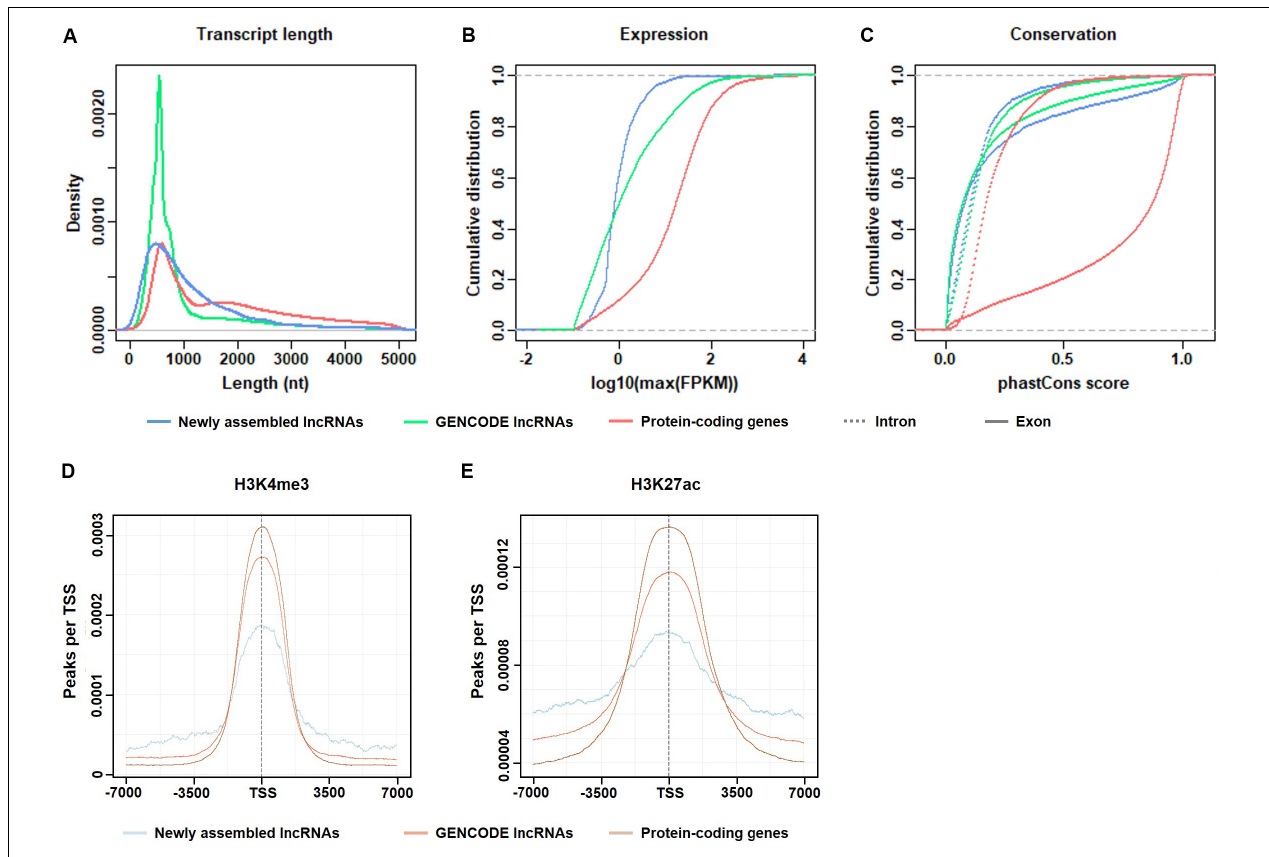
FIGURE 2 | Basic features of the candidate lncRNAs. (A) Length distribution of the transcripts. (B) Maximum expression level (FPKM) of the transcripts. (C) Exonic/intronic conservation of the transcripts. (D) H3K4me3 enrichment near the TSS of candidate lncRNAs, GENCODE lncRNAs, and protein-coding genes. (E) H3K27ac enrichment near the TSS of candidate lncRNAs, GENCODE lncRNAs and protein-coding